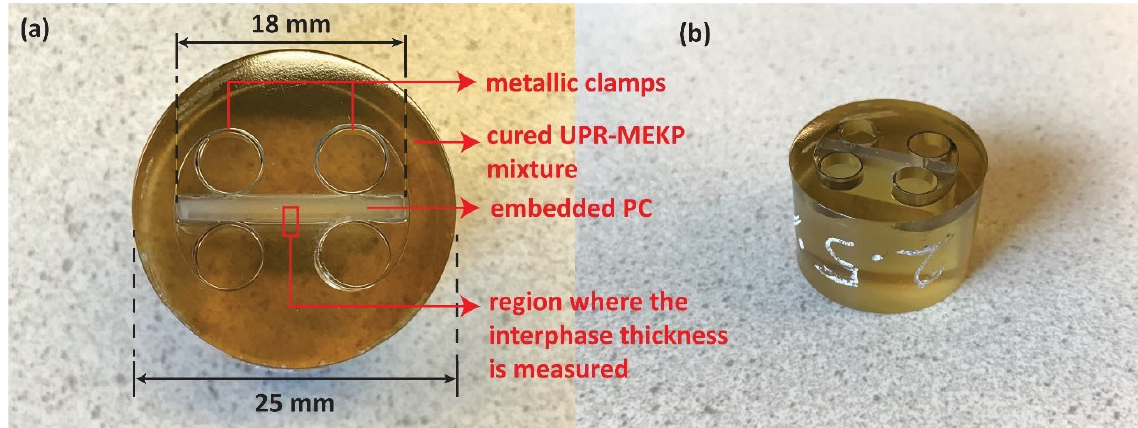
Figure 1. ( a ) Top and ( b ) isometric views of the co ‐ bonded PC and UPR ‐ MEKP.